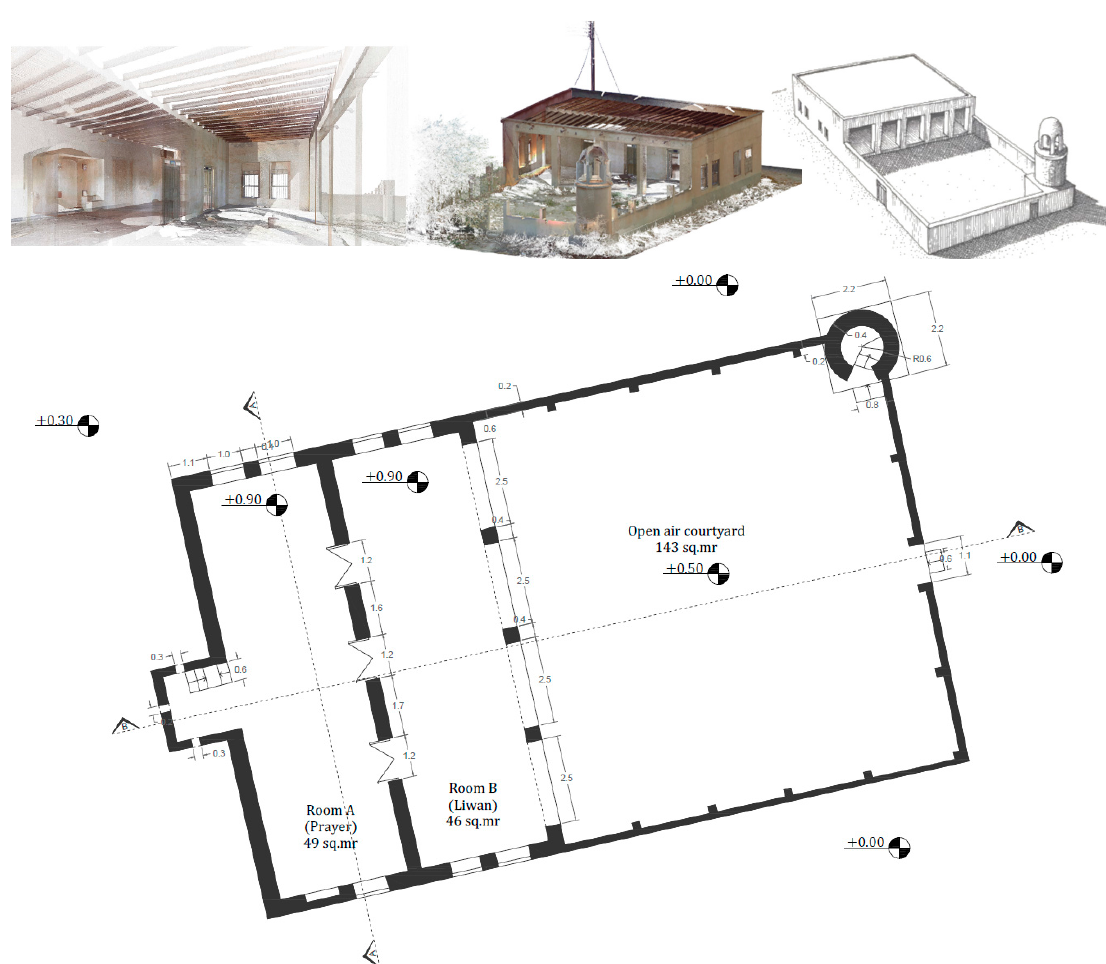
Figure 14. Tinbak Mosque, its plan with a 3D sectional view for the mosque displaying, from left to right, the haram, colonnaded area and part of the courtyard. Moreover, two perspectives; the upper right one is Tinbak Mosque. The lower right one (the black and white) is a view of a typical mosque similar to that in Tinbak (printed with permission from the author Jaidah and Bourennane, 2009).